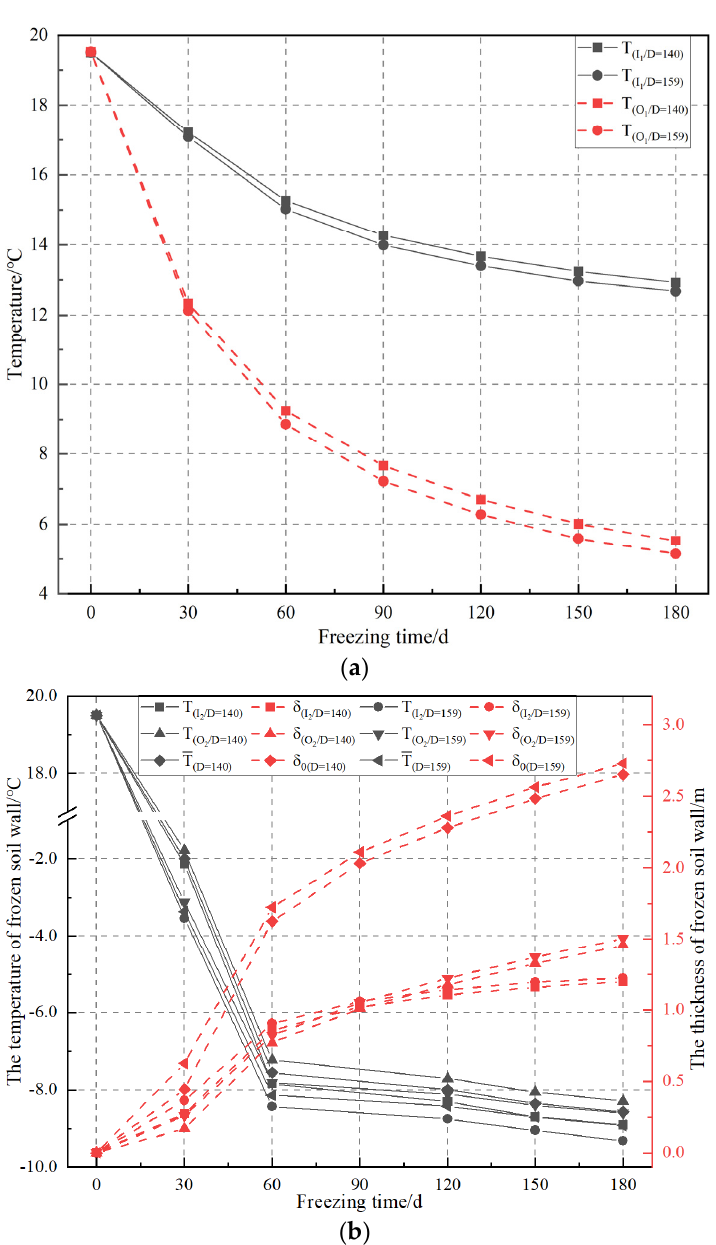
Figure 14. Variance in temperature and thickness under different freezing tube diameters and freezing time: ( a ) temperature in interlayer and outside wall of shaft, ( b ) temperature and thickness in the inside and outside of frozen soil wall and its average or sum value with freezing tube diameters of 140 mm and 159 mm.